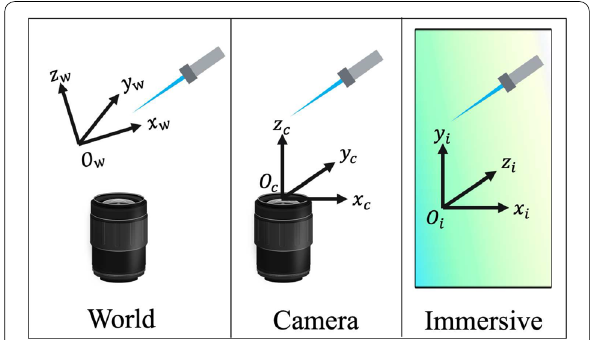
Algorithm 1. The real-time 3D microscope obtains the position of the microscopic object in the immersive space